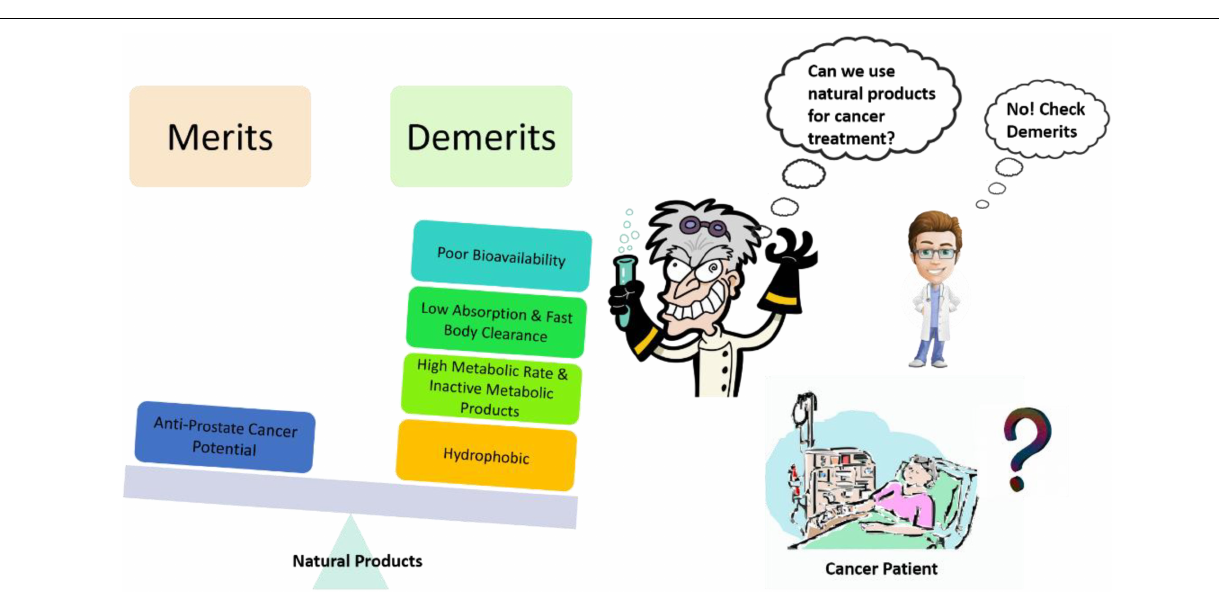
which might also be a reason behind the mortality of